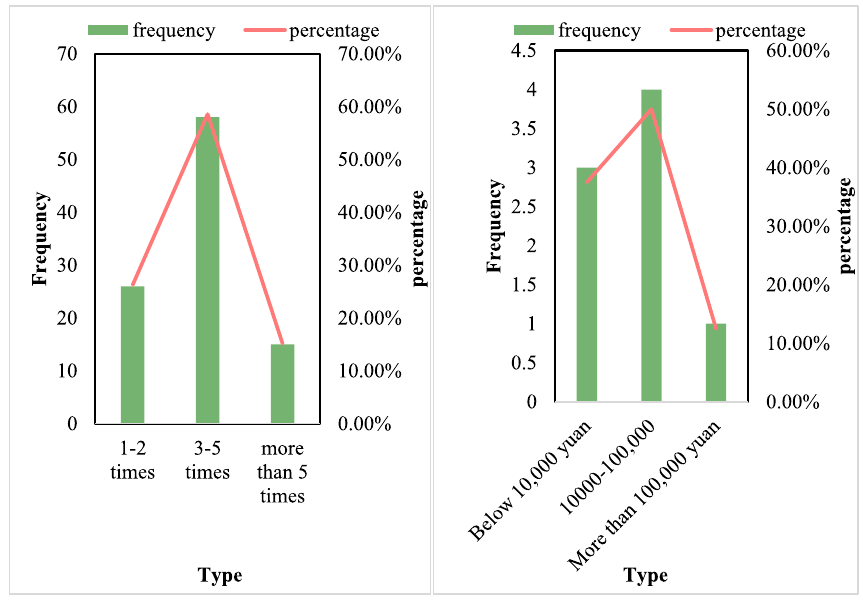
Fig. 9 The number of frauds and the amount of fraud. a The number of fraudulent calls or text messages received. b The amount of fraudulent citizens who were defrauded